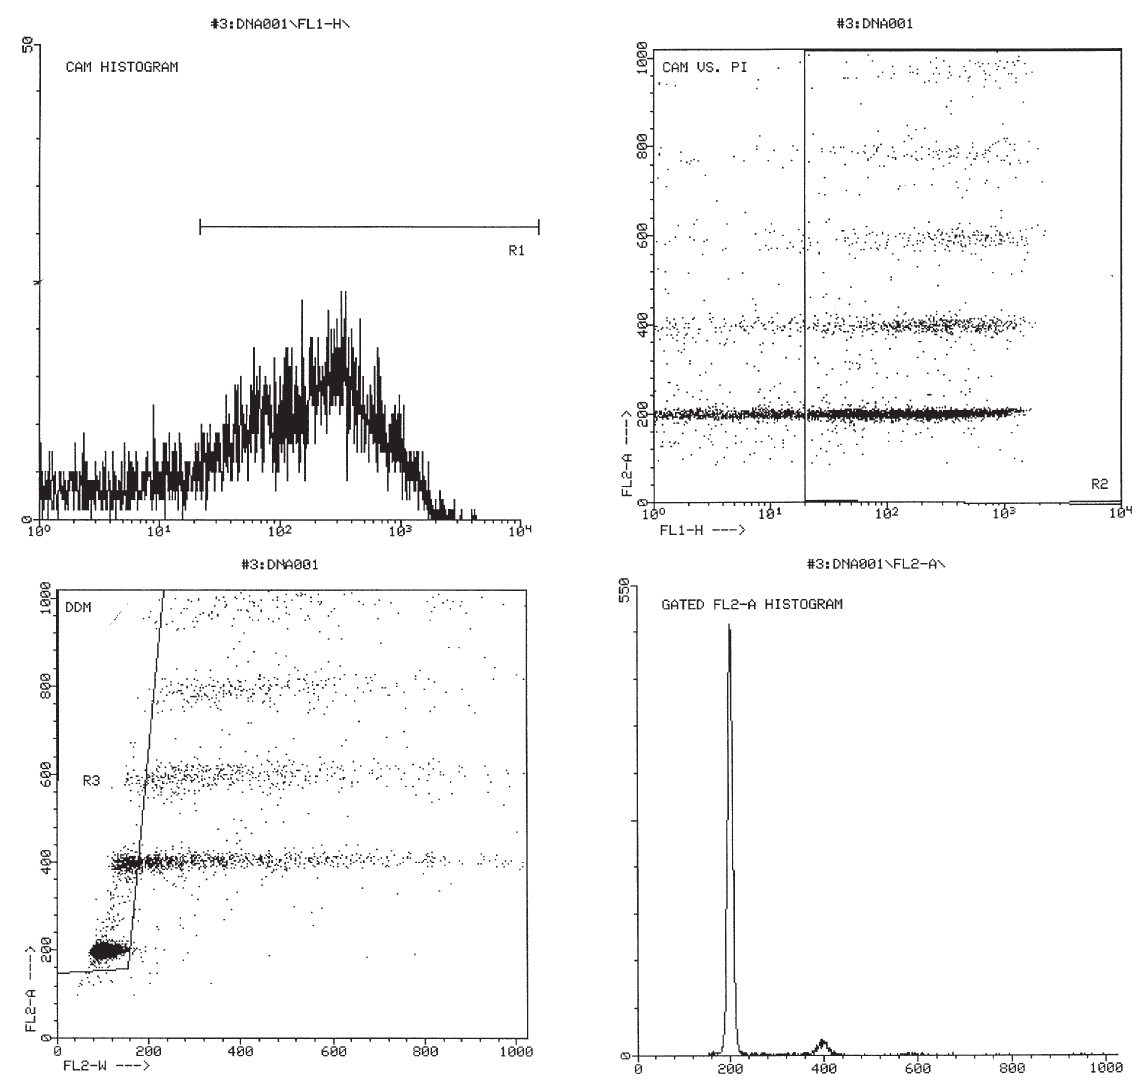
Fig. 1. Top left: fluorescence-1 (green fluorescence) histogram exhibiting a population of cytokeratin positive cells, designated by R1. Top right: histogram of DNA content (vertical axis) versus cytokeratin fluorescence intensity (horizontal axis). The R1 gate is illustrated by the vertical line. Note the presence of populations corresponding to aggregates. Lower left: gate R3 corresponding to the aggregate subtraction component of the doublet discrimination module. Lower right: cytokeratin gated DNA histogram, demonstrating a unimodal G0G1 population with low coefficient of variation and minimal debris or